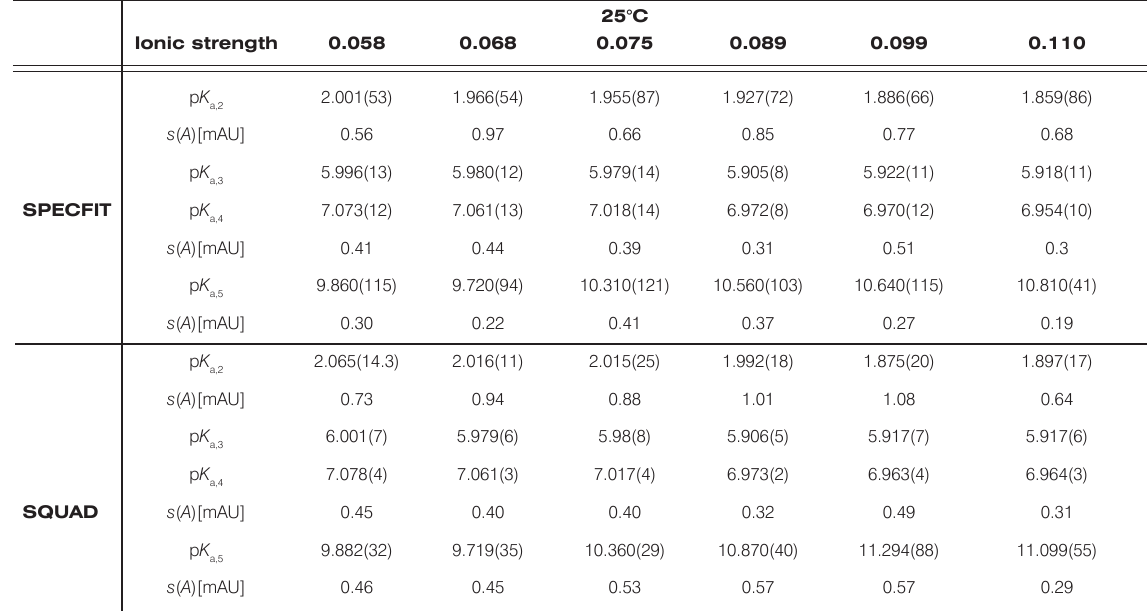
Table 2. Mixed dissociation constants p K of risedronate at 25°C and various values of an ionic strength I estimated by nonlinear regression a,i programs SPECFIT and SQUAD. Standard deviations of parameter estimates in last valid digits are in